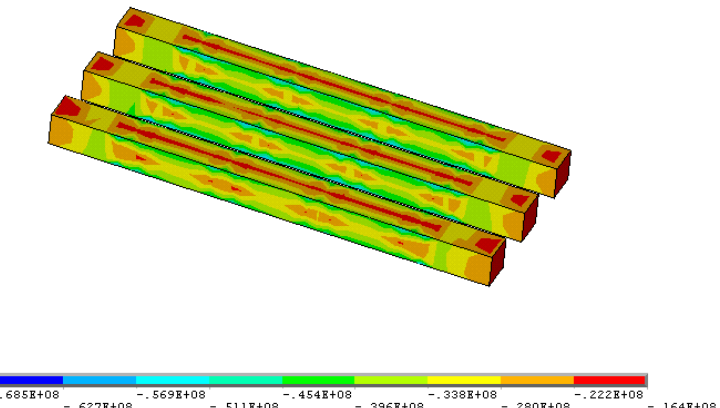
Figure 10. Maximum principal stress distribution in the ore block at 1480 mL after mining the strip room (parameters before optimization: stope height 3 m, pillar diameter 3 m, pillar spacing 7 m, pillar row spacing 9 m).